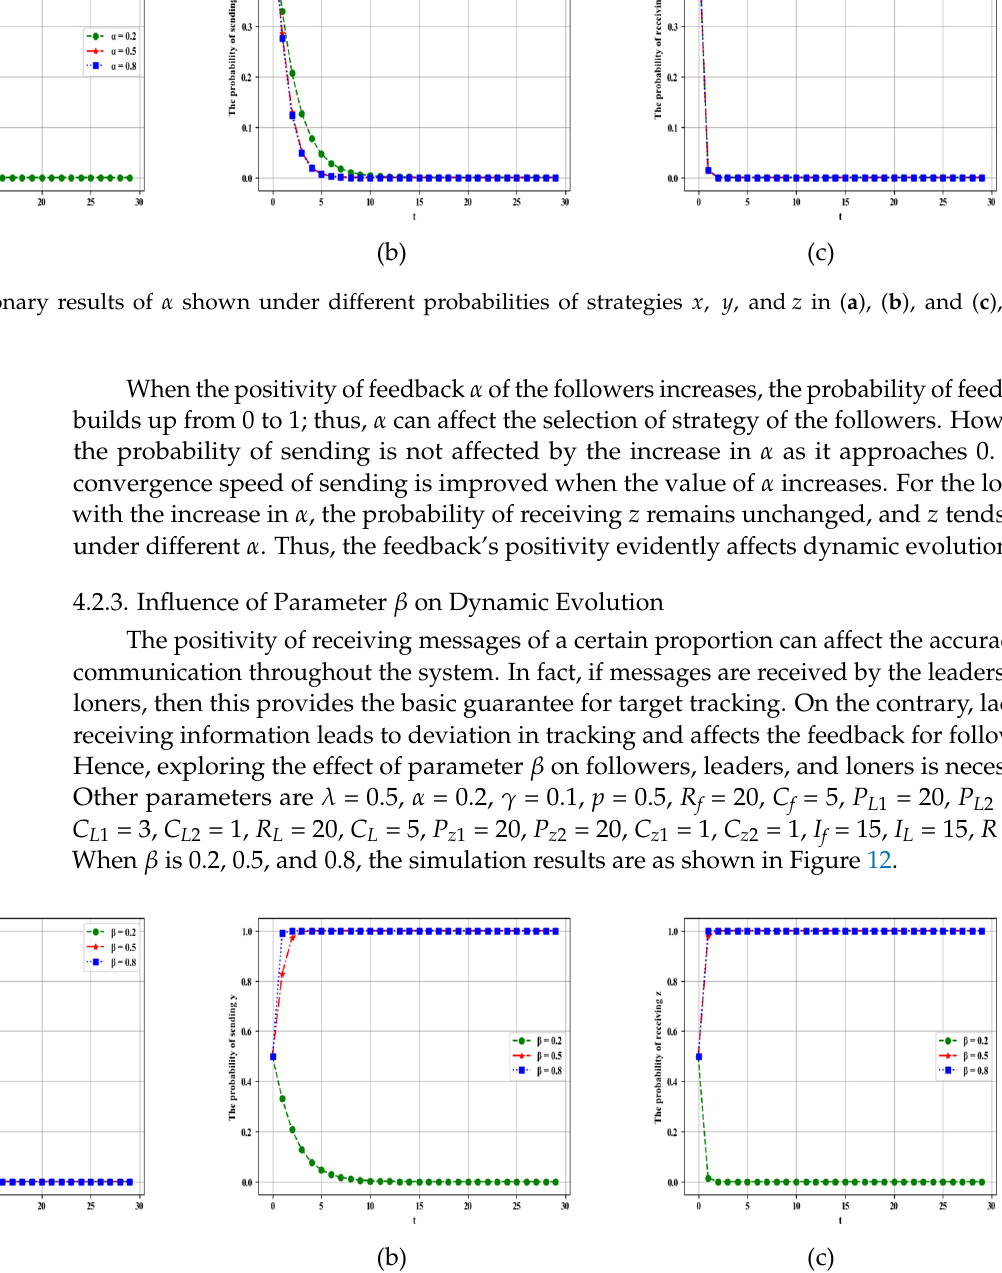
Figure 12. Evolutionary results of 𝛽 shown under different probabilities of strategies 𝑥, 𝑦, and 𝑧 in ( a ), ( b ), and ( c ), respectively.